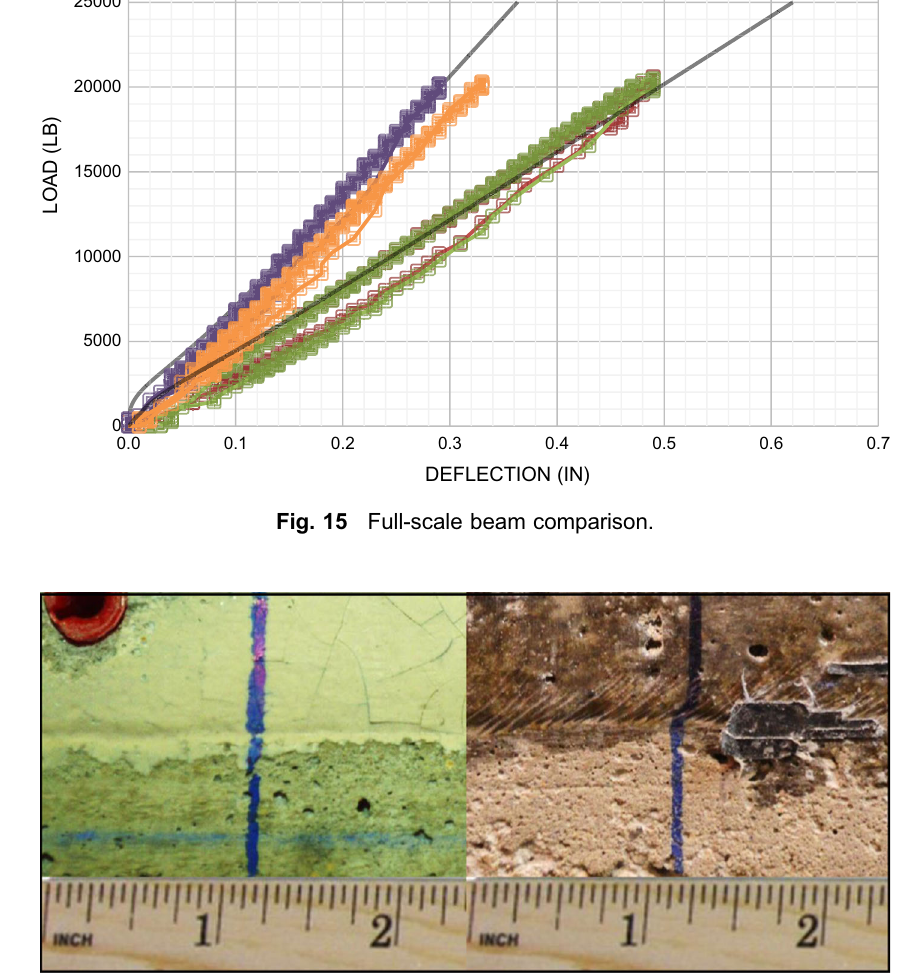
Fig. 16 Shear movement comparison; inorganic ( left ), organic ( right